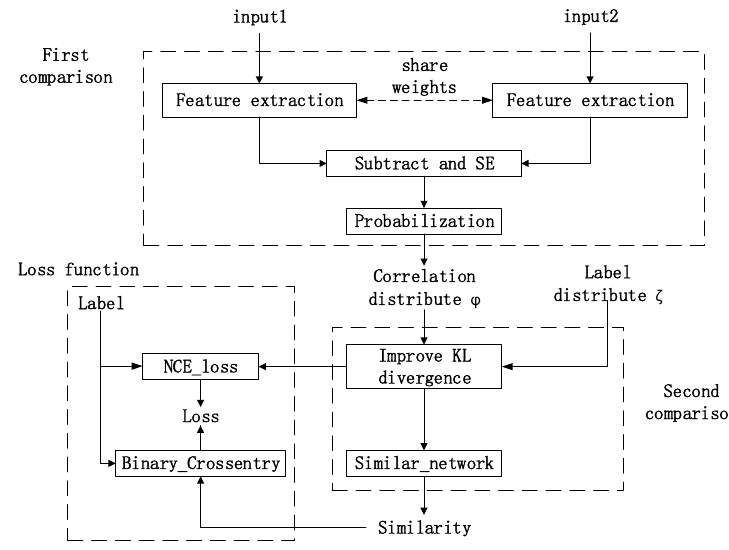
Figure 3. Network architecture.